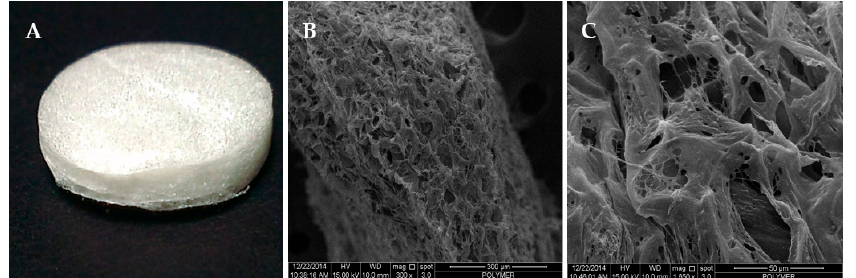
Figure 2. The freeze-dried collagen type I (Col I) sca ff old at − 80 °C: ( A ) overall view, ( B ) view under scanning electron microscope (SEM) at 300×, and ( C ) view under SEM at 1650×.